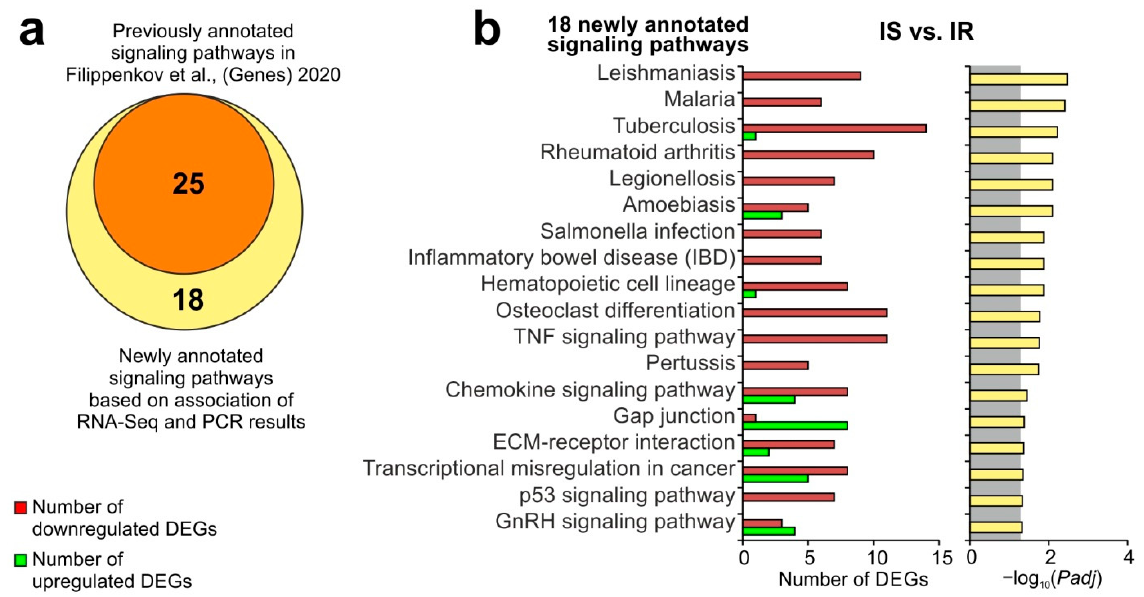
Figure 3. Update of signaling pathways associated with DEGs in IR versus IS based on the combination of RNA-seq and RT-PCR results after 24 h under tMCAO conditions. KEGG database analysis of DEGs was carried out using the DAVID database. ( a ) The number of signaling pathways that overlapped between previous and new enrichment results [15]. ( b ) The number of upregulated and downregulated DEGs, as well as the p -values, adjusted using the Benjamini–Hochberg procedure ( Padj ) for 18 newly annotated signaling pathways. Only those genes and signaling pathways where Padj < 0.05 were selected for analysis. Those with Padj ≥ 0.05 are against a gray background.